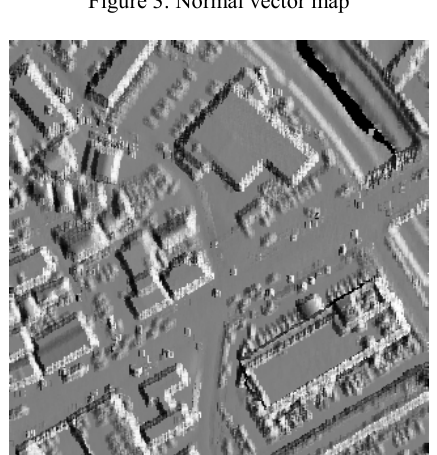
Figure 3. Normal vector map